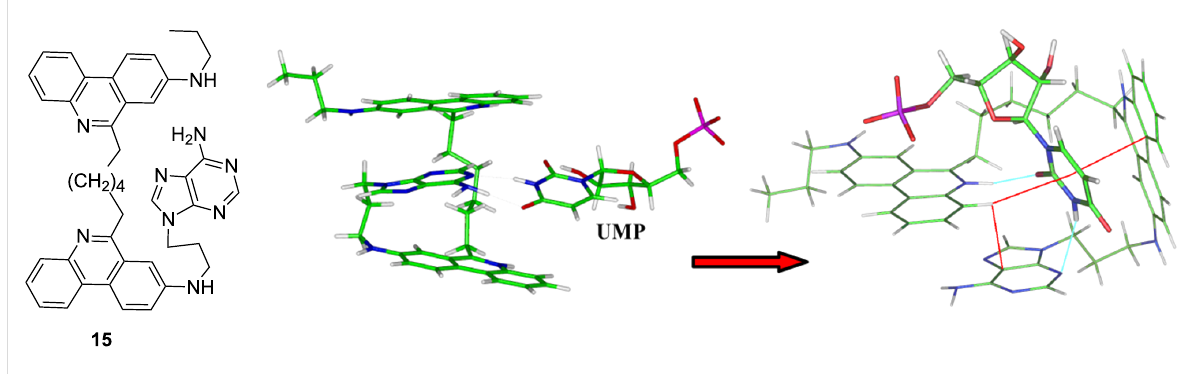
Figure 6: The bis-phenanthridinium–adenine derivative 15 (LEFT) showed selectivity towards complementary UMP; structure of the 15 –UMP com- plex (RIGHT) obtained by molecular modelling. Reproduced with permission from [75]. Copyright 2010 Elsevier Ltd.